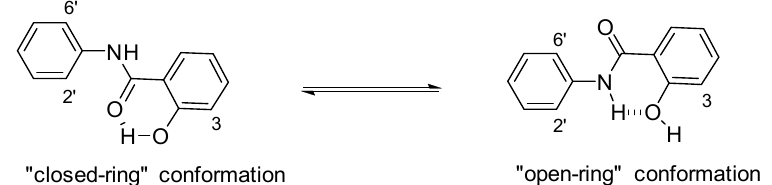
Figure 3. Conformational equilibrium in salicylanilide molecules. Two possible intramolecular hydrogen bond formations resulting in closed-ring or open-ring conformation [52].